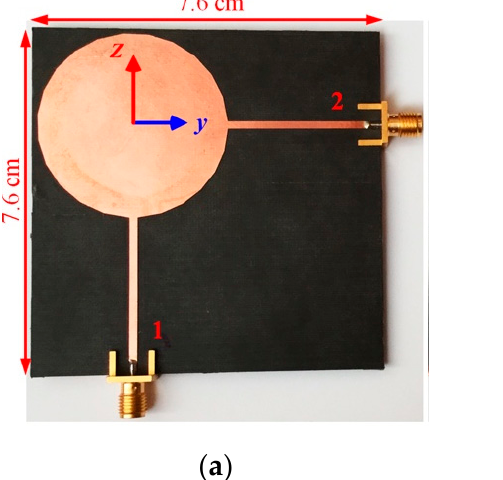
Figure 6. Fabricated two-port antenna: ( a ) top view; and ( b ) bottom view.